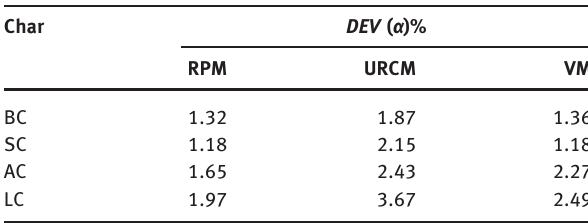
Table 4: Deviation between the experimental and calculated